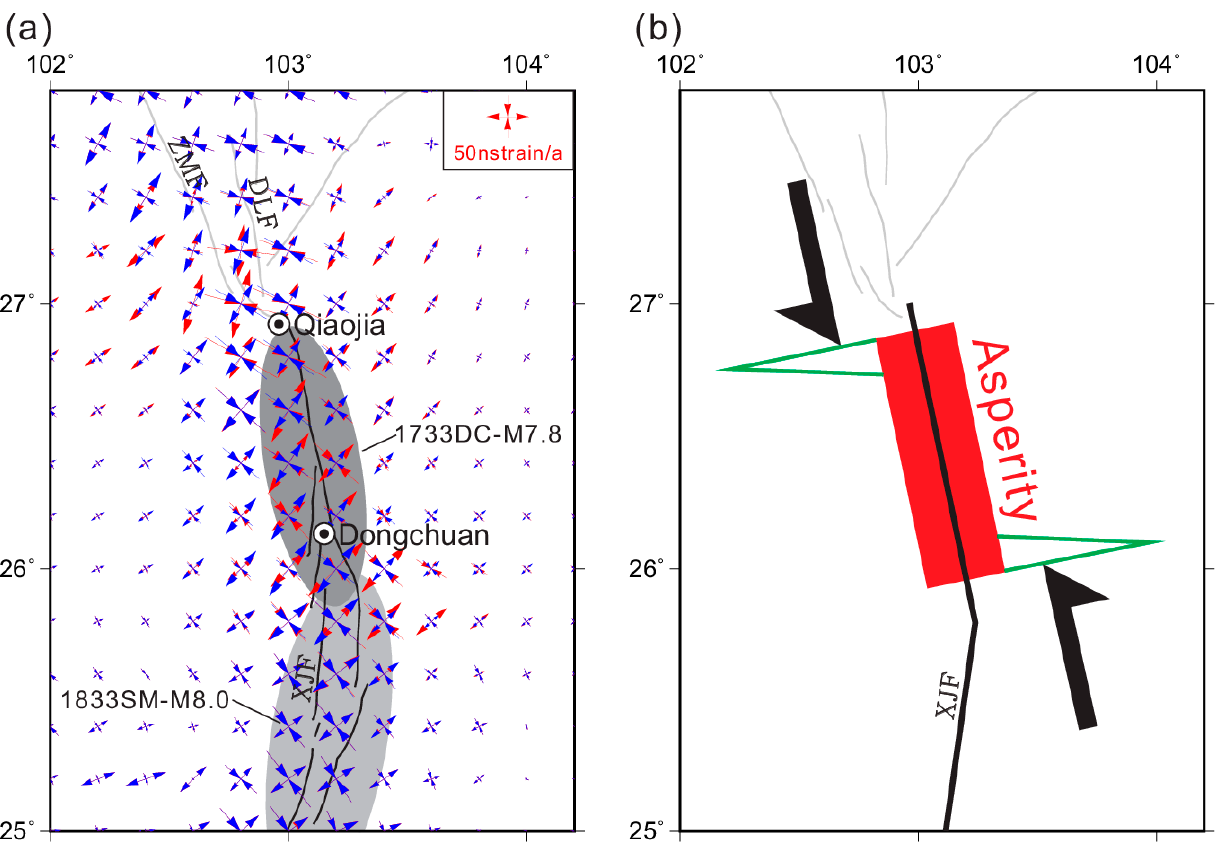
Figure 7. The spatial pattern of the strain rate tensors from the regional GNSS observations only (blue) and the combination of the regional and our near-fault GNSS observations (red). ( a ) The difference revealed by the comparison of the strain rate tensors from the two types of datasets. ( b ) The asperity revealed by D-model (Figure 4) is used to explain the difference shown in Figure 7a. The red filled box represents the locked asperity, the two green wings show the obviously deformed areas at the two tips of the locked asperity, and a pair of large black arrows indicates the driving force to the locked asperity due to the left-lateral strike slip of the XJF.